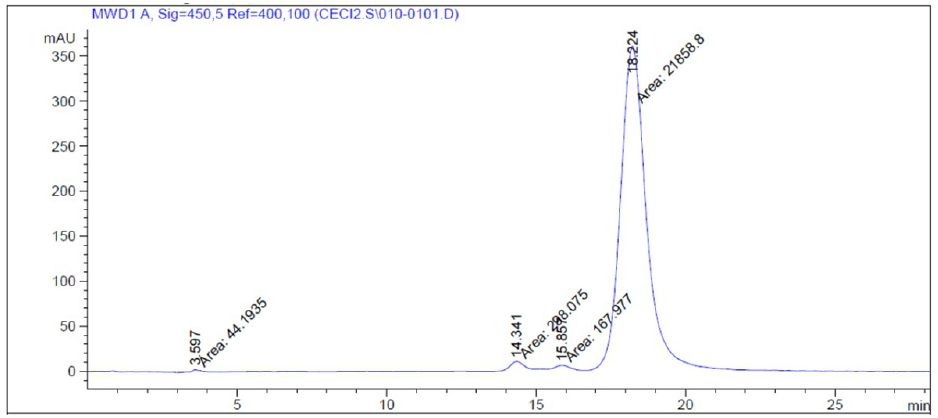
Figure A1. Cromatogram of Bixin after extraction. Foods 2019 , 8 , x FOR PEER REVIEW